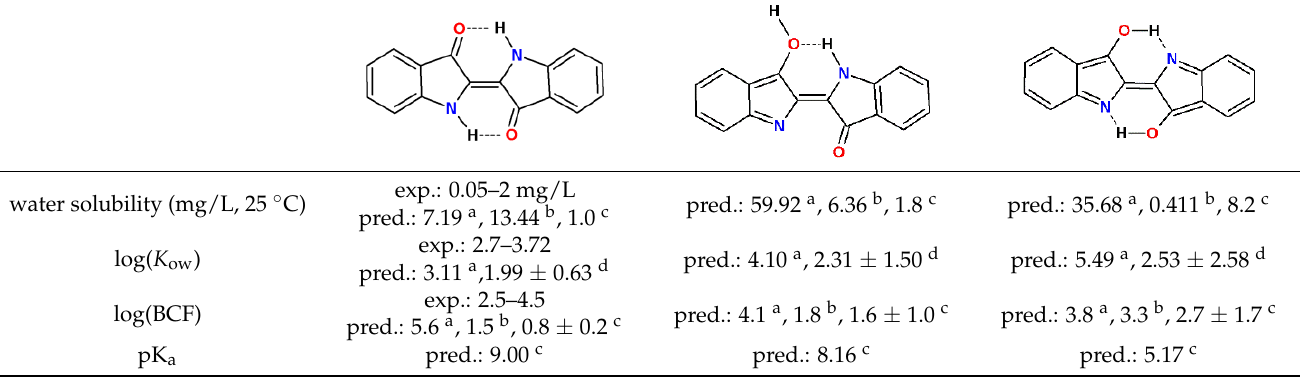
Figure 3. ( A ): indigo layer formed upon filtration. ( B ): pure E-indigo on a friction felt. The metallic luster observed on both photographic images indicates that larger indigo structures have formed by self-assembly from suspension or by friction, respectively [46].